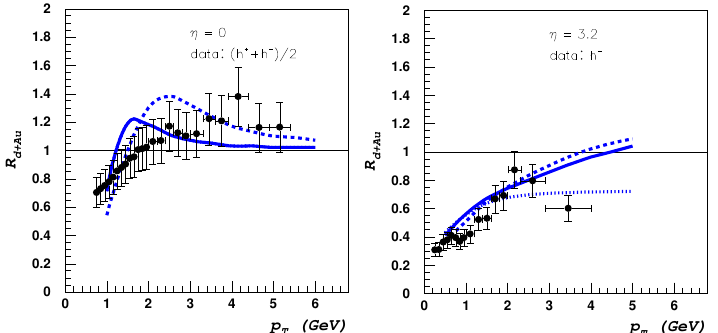
Figure 19. BRAHMS data on the nuclear modification factor R dAu of charged particles at midrapidity and forward rapidity (data from [110]) compared with the saturation based results in [113]. The midrapidity p distribution is characterized by a Cronin peak, while at forward rapidities this peak ⊥ is washed